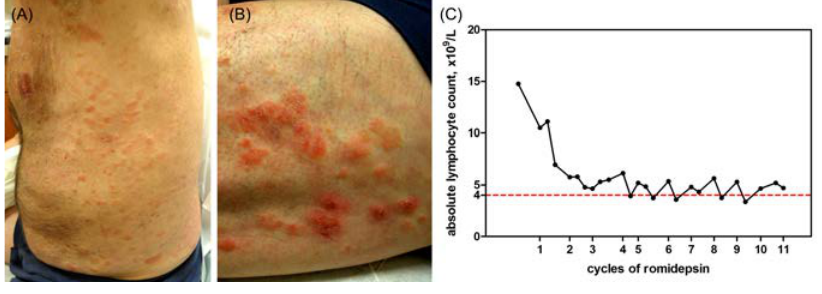
Figure 1. Clinical presentation of mycosis fungoides. Symmetrical confluent eczematous patches and plaques on the flanks (A) and upper thighs (B). Treatment with